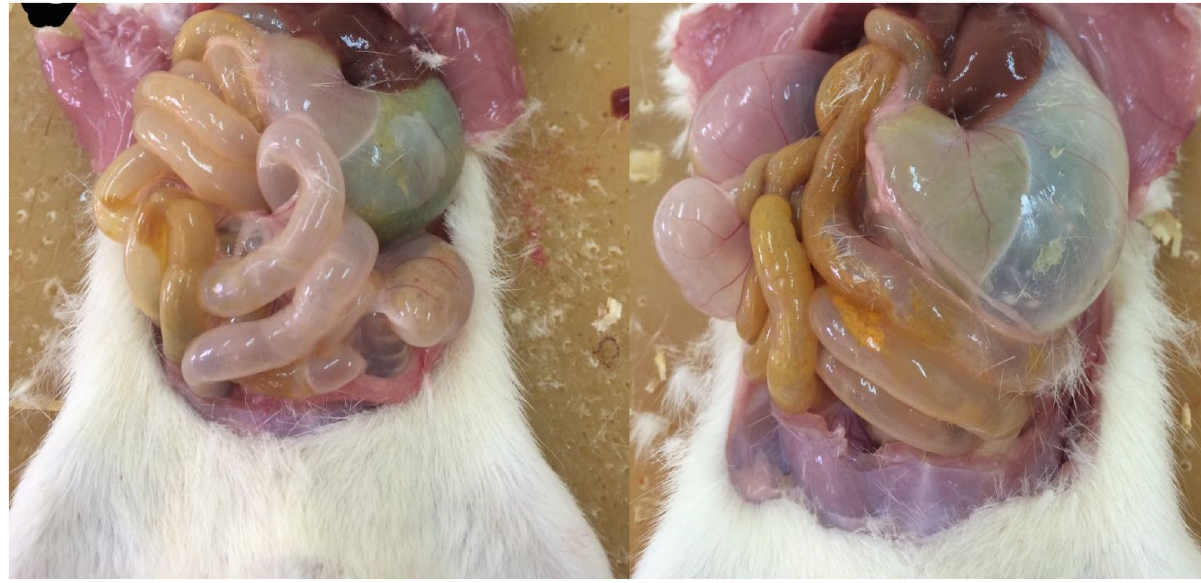
Fig 2. Two examples on the swelling of the gastro-intestinal tract of the rats belonging to the group of 500 mg aerogels.